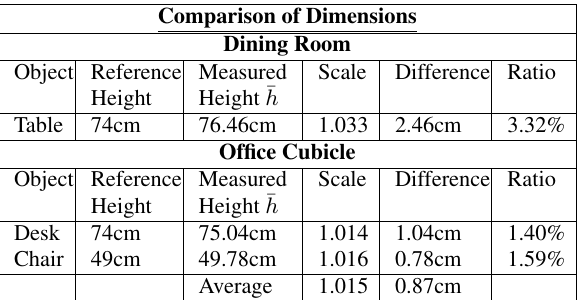
Table 9: Table showing the effect of scaling each scene such that the objects are closer to their respective reference